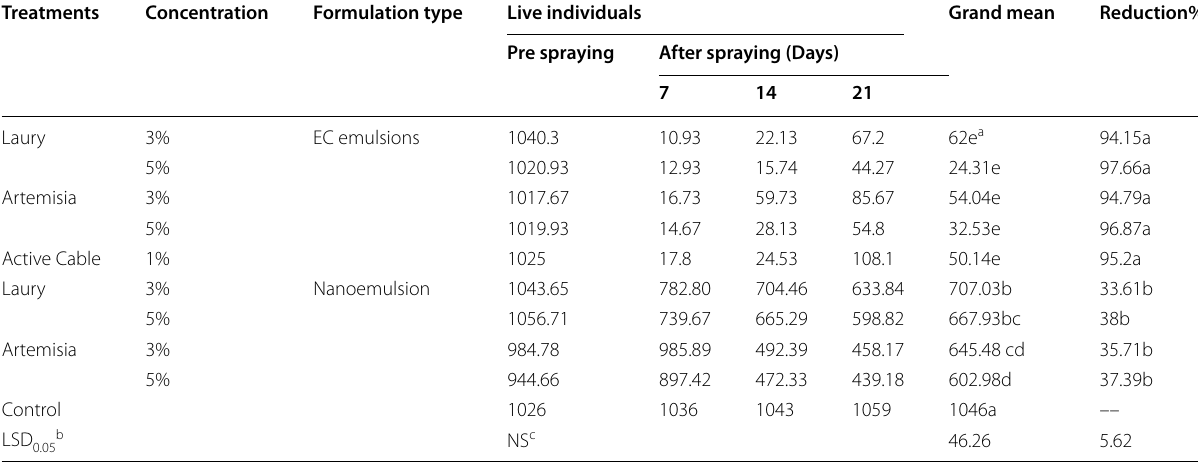
Table 4 Insect females of Parlatoria ziziphi affected by application of two formulation types based on the plant essential oils in citrus